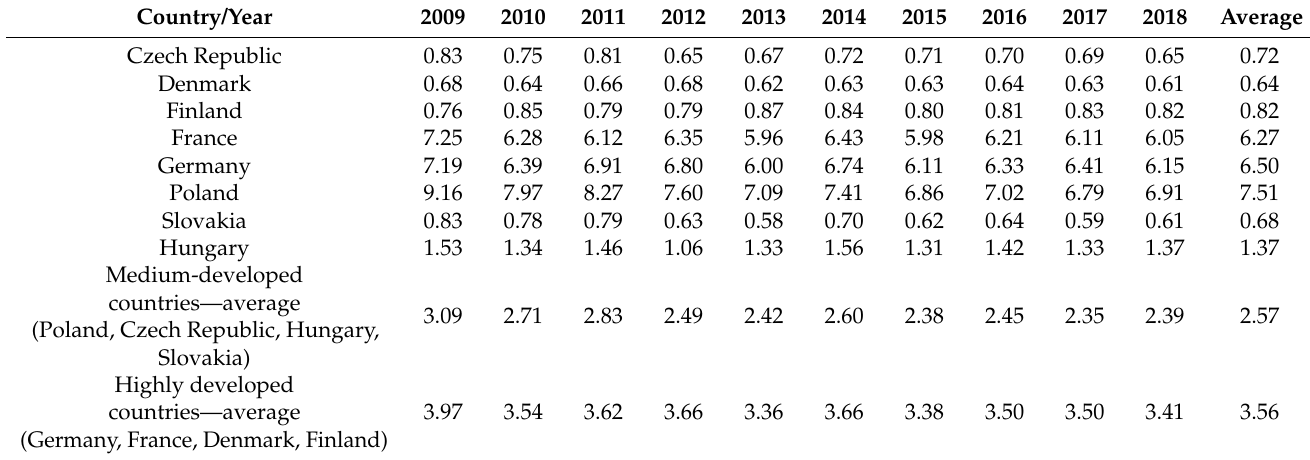
Table 6. Biomass consumption per GDP per capita in USD in the surveyed EU countries (thousand tonnes).